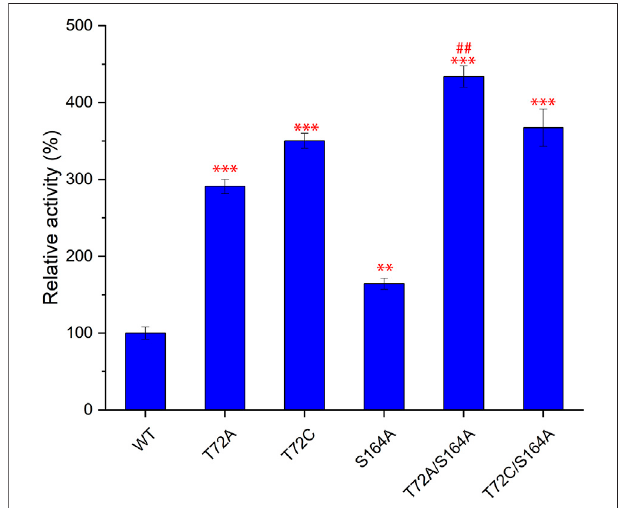
FIGURE 4 | Comparison of catalytic function of different mutants. 5 ′ - FDA was measured after 45 min of incubation at 50 ° C in the presence of puri fi ed enzyme (50 μ g/ml). Error bars represent the standard deviation obtained from three replicates. ** p < 0.01 vs. WT; *** p < 0.001 vs. WT; # # p < 0.01 vs.